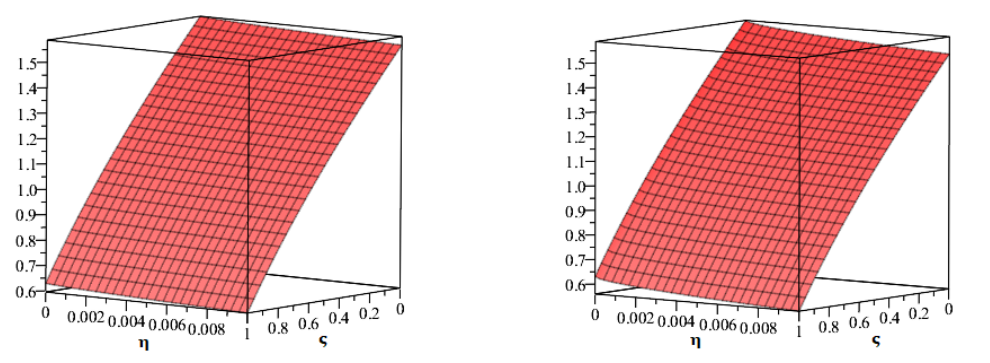
Figure 8. The proposed method solution at γ = 0.8,0.6 for example 3.